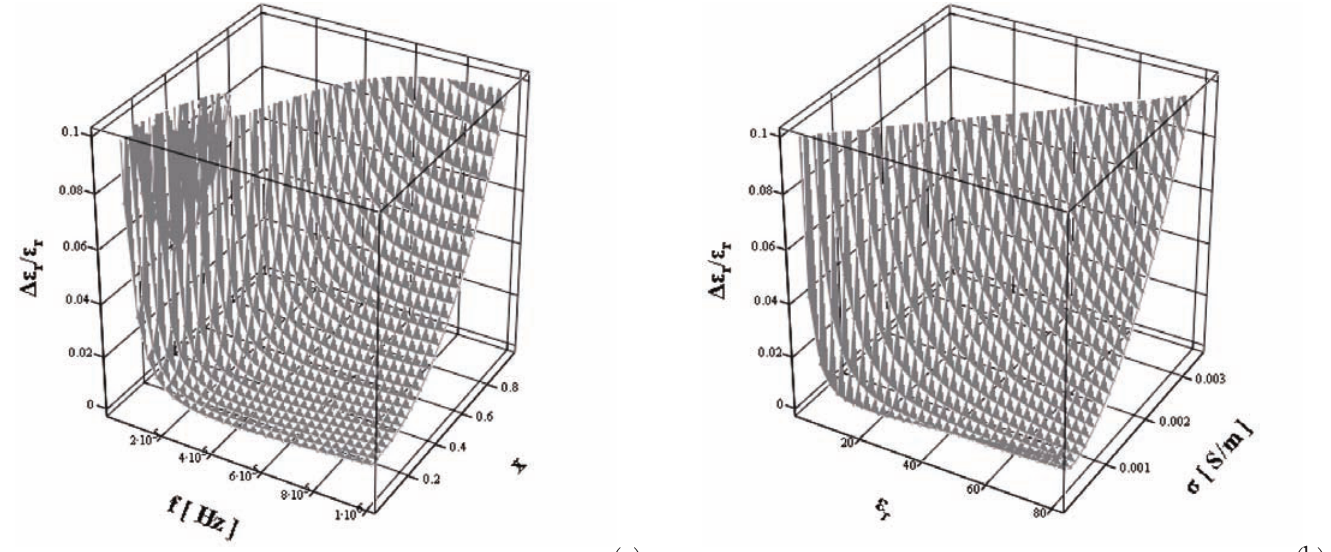
Figure 3. On the hypothesis that D | Z |/| Z |= DU function Df / f ( f , x ) of both the frequency f in the band f ∈ [0, f r r characteristic geometrical dimension L , as 0 < x ≤ 1, when the quadrupole probe designed in the linear Wenner configuration has a capacitive contact on a non-saturated concrete of low electrical conductivity, i.e. v = 10 −4 S / m , f f r , when the quadrupole working in a fixed band B = 100 kHz is in galvanic contact on a class of concretes such that v ∈ [10 −4 S / m , 2·10 −2 S / m